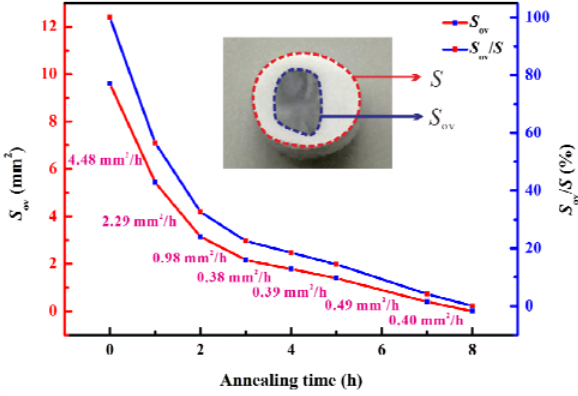
Fig. 3 Variations of S ov and S ov / S as a function of annealing